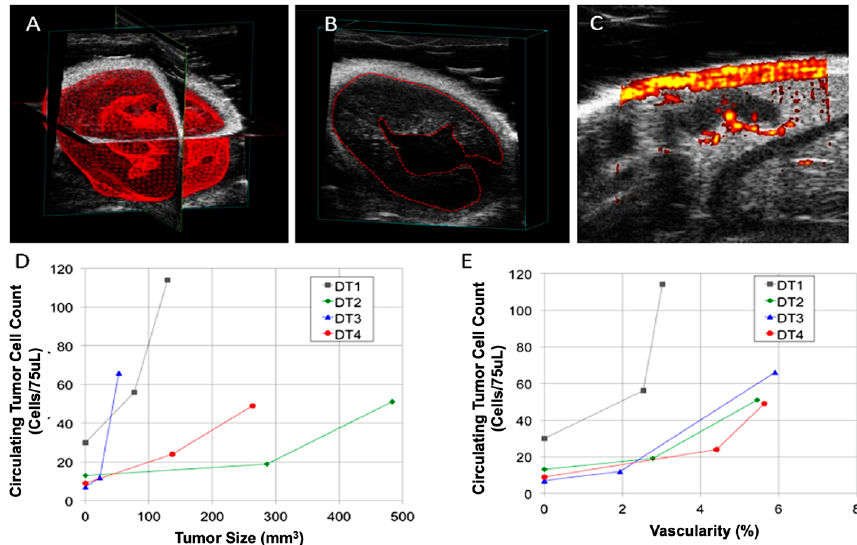
Figure 5. Evaluation of tumor size and vascularity in NTTg mice over time, and correlation with CTC count. ( A ) A reconstructed 3D model of a tumor acquired from an ultrasound scan. ( B ) The volume of the tumor was determined by outlining its contours in the scan. The outline of the tumor includes the mucinous pool. ( C ) Vascularity of a lymph node, as determined by an embedded Doppler function in the ultrasound scan. ( D ) The correlation between tumor size and CTC count. ( E ) The correlation between vascularity and CTC count. The lines in ( D , E ) are provided only to guide the eye.